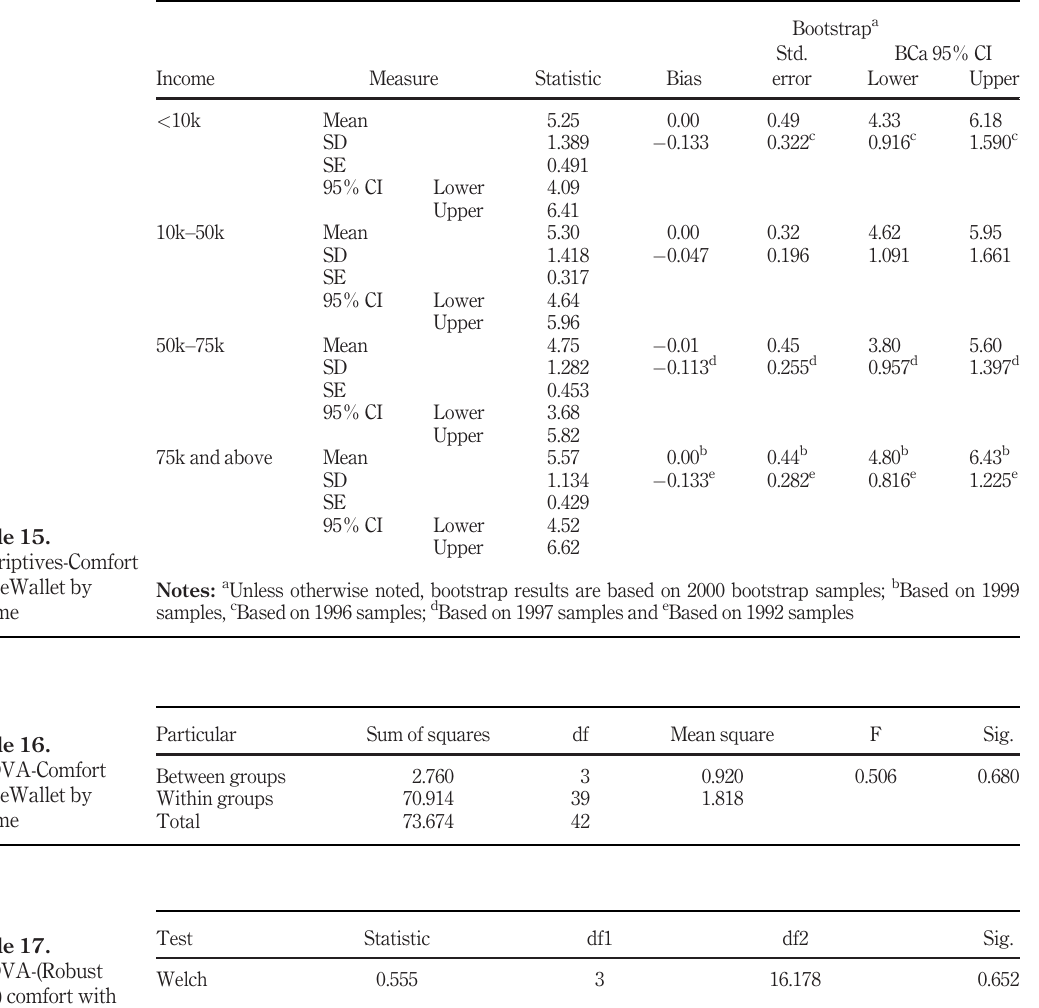
Table 17. ANOVA-(Robust tests) comfort with eWallet by income